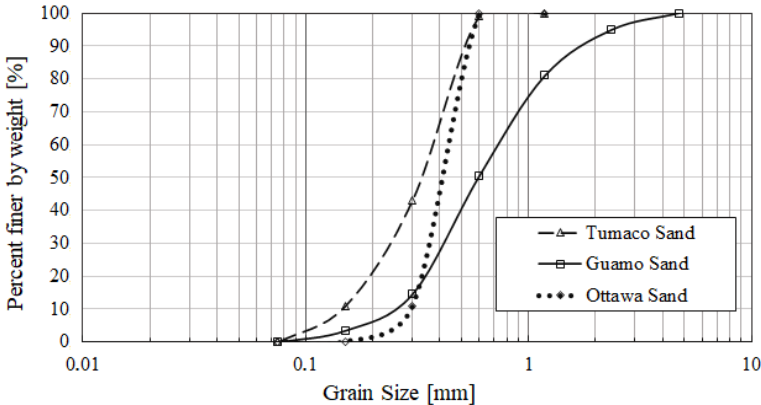
Figure 10. Grain size distribution curve for Tumaco, Guamo, and Ottawa sands.